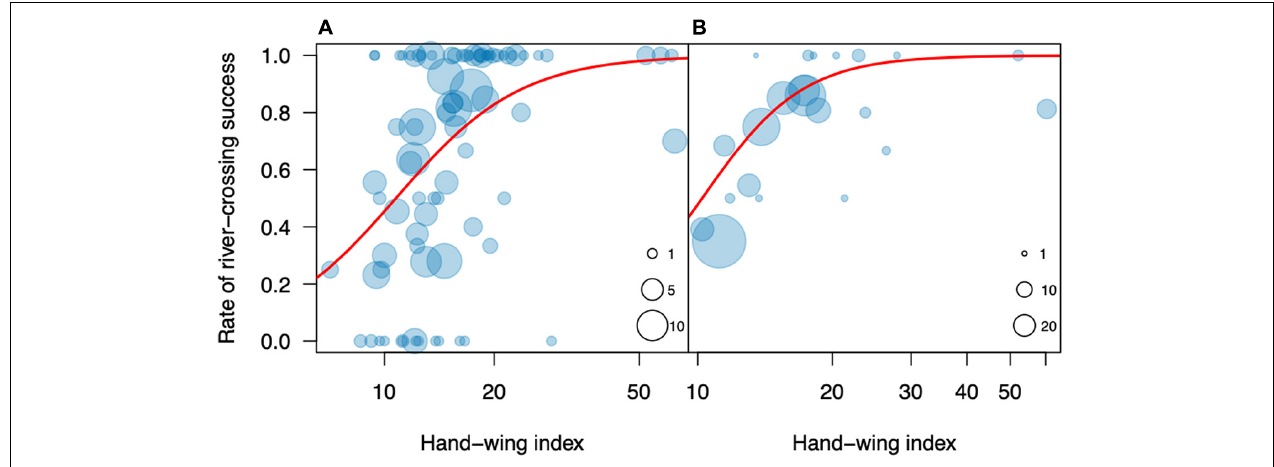
FIGURE 2 | Rate of river-crossing success in the dispersal experiments on the Rio Branco in relation to the Hand-wing index at the species (A) and family (B) levels. In panel (A) , each circle represents one species, and its diameter represents the number of individuals for that species. In panel (B) , each circle represents one family, and its diameter represents the number of species for that family.